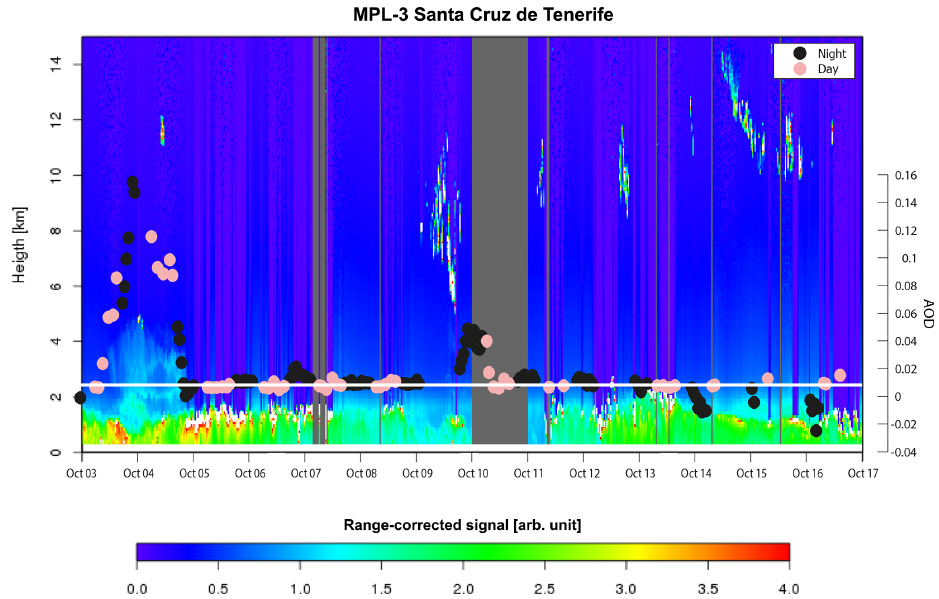
Figure 1. Lidar range-corrected backscattering signal from the MPL-3 installed at Santa Cruz and AOD (at 500nm) evolution (day in pink circles and night in black circles) extracted from the CE318-T installed at Izaña in October 2014. Horizontal white line represents the Izaña observatory altitude.